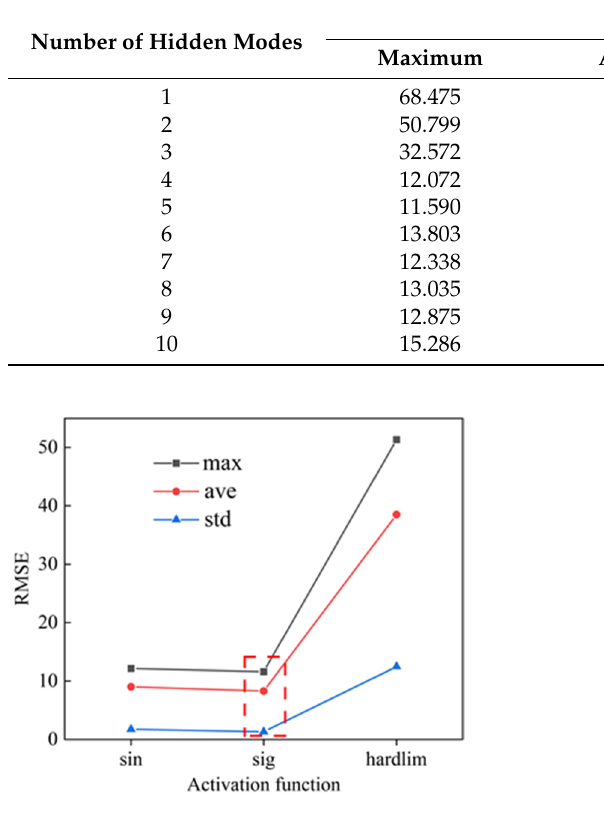
Figure 5. Effects of the activation function on the ELM